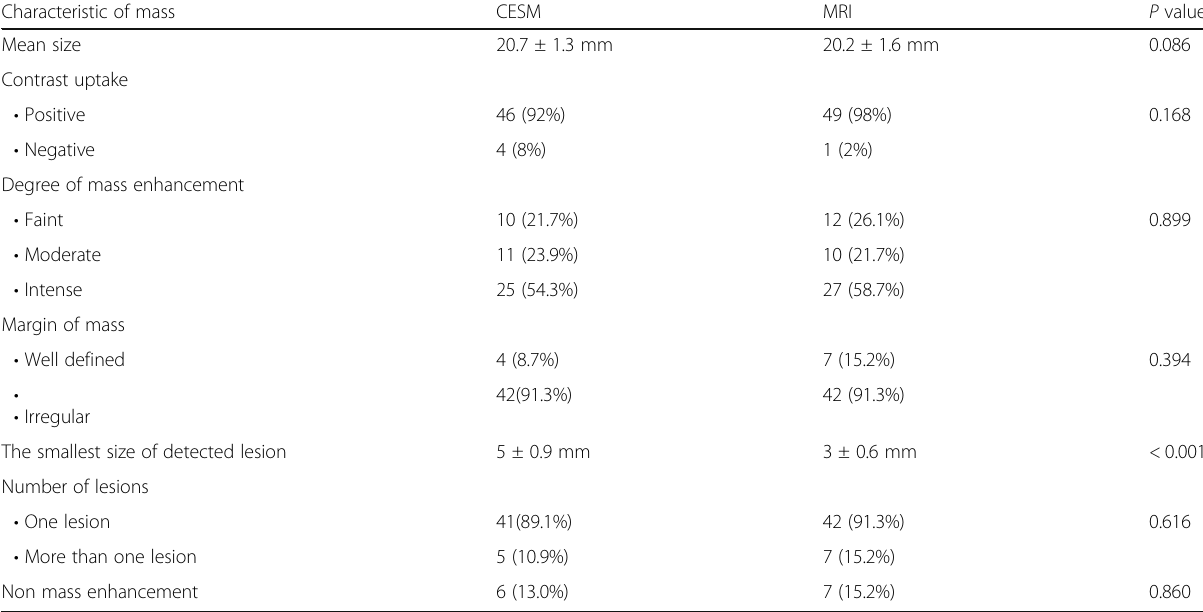
Table 2 The criteria of lesions on CESM and MRI Characteristic of mass CESM